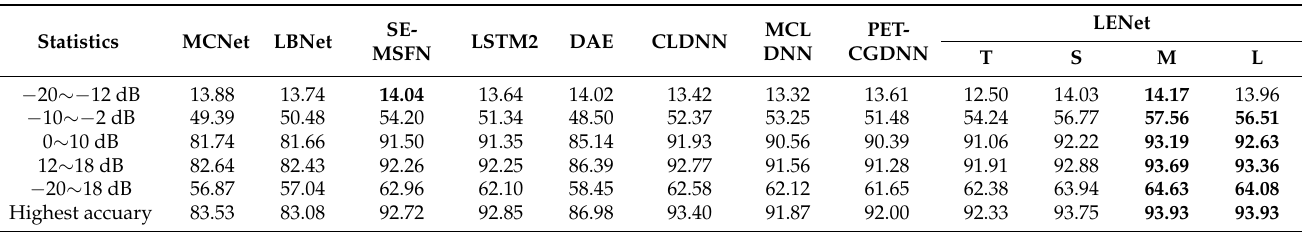
Figure 6. Classification accuracy of all models against SNR on the ( a ) 2016A, ( b ) 2016A (hyperparam- eter optimization), ( c ) 2016B, and ( d ) 2018A dataset. Table 3. Results of statistical analysis of all models’ classification accuracy on the 2016A dataset. The top2 for each statistic are